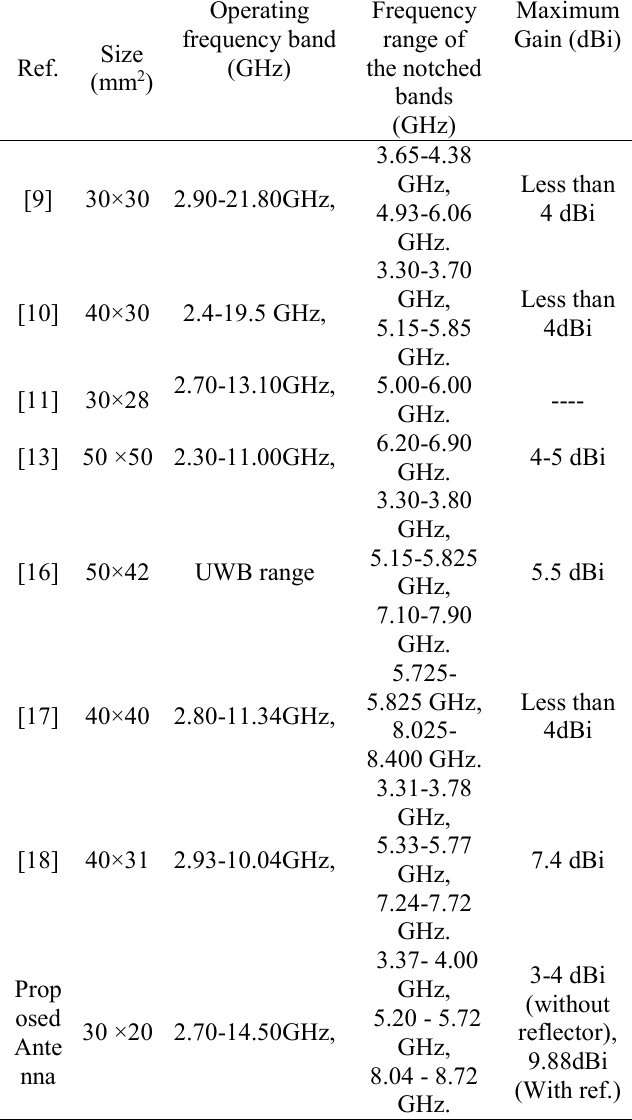
Table 3: Comparisons of performance of the